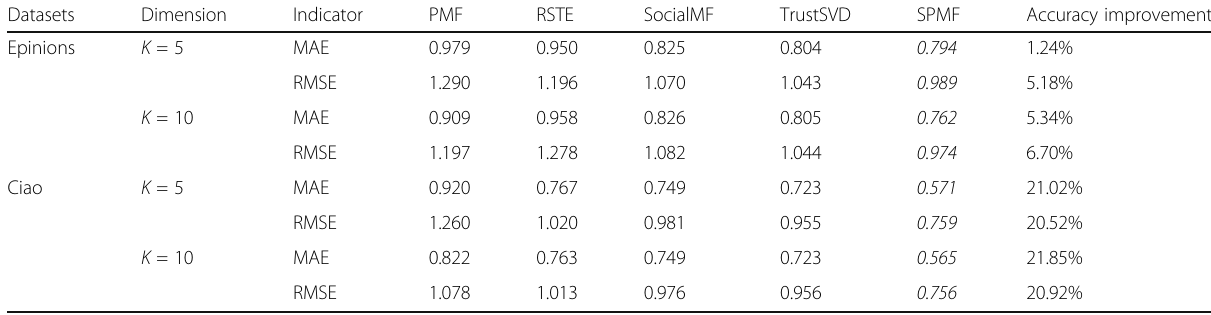
Table 4 RMSE comparison with baselines